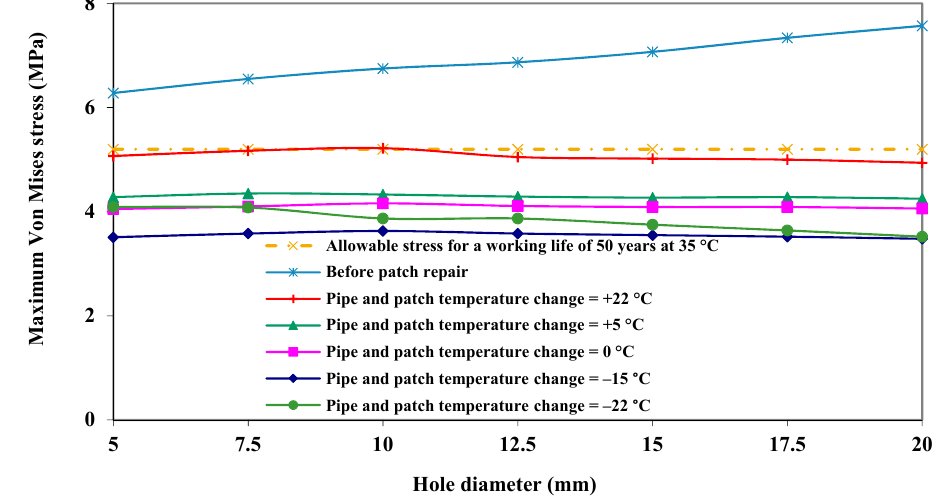
Figure 11. Maximum Von Mises stress variations in the buried pipe for various size circular hole defects repaired by semi-cylindrical patch (the simultaneous effect of soil load, internal pressure, vehicle wheel load and temperature variations).